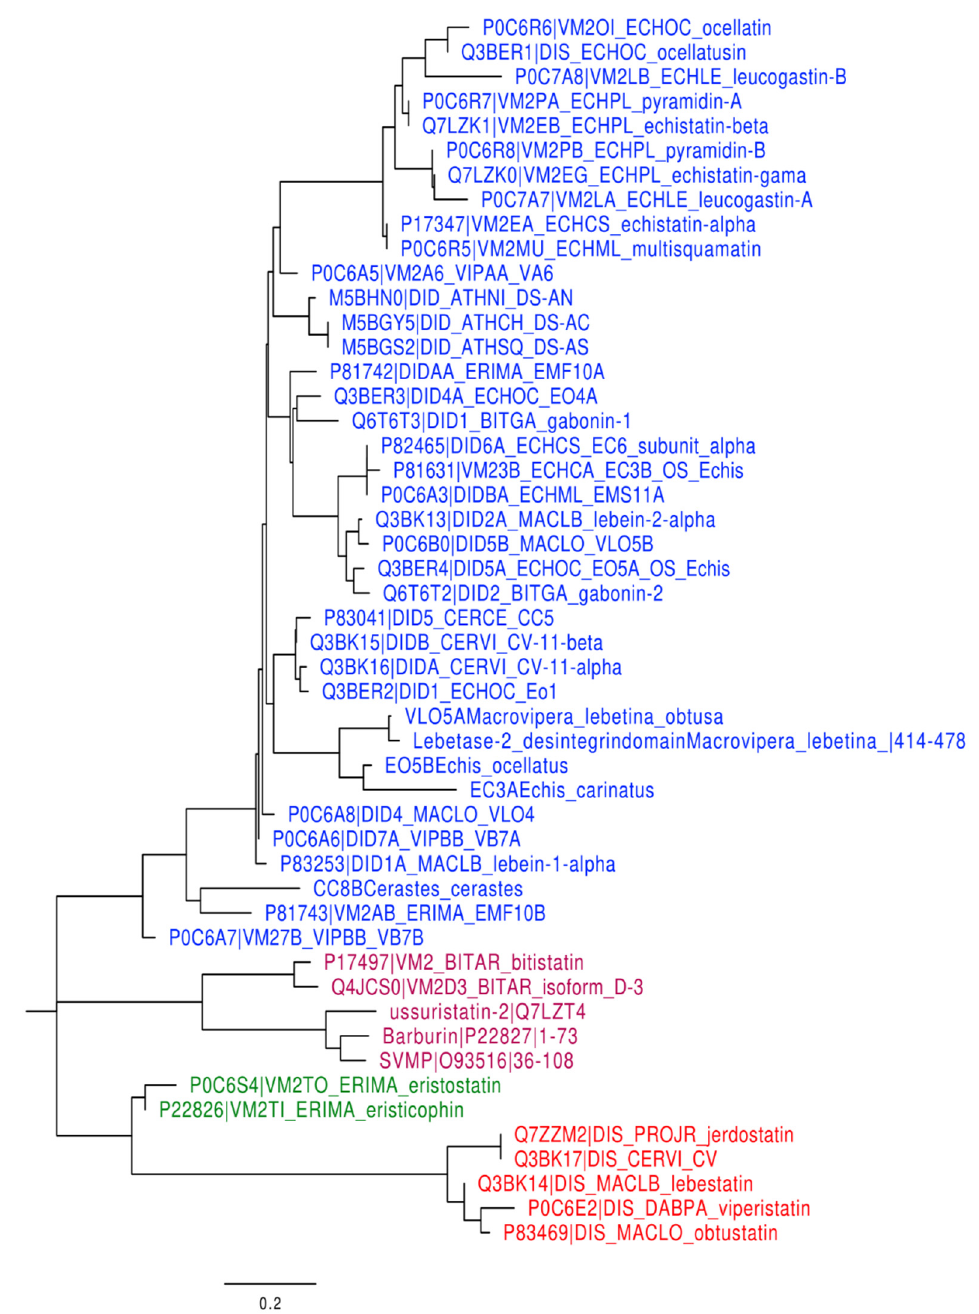
Figure 2. Phylogenetic tree of the disintegrins family. Phylogenetic analyses by JTT matrix-based method of all disintegrins family based on the RGD, KGD and R/KTS motifs. This analysis involved 50 amino acid sequences. Topology was supported by 1000 bootstrap replicates. The red color highlights the KTS-disintegrin family. Short disintegrins divided into groups, the color blue highlights the RGD group (24 disintegrins) and the RGD like group (14 disintegrins) includes seven MLD, five KGD, one MGD, four VGD and two WGD, Eristostatin group (green), KGD group (pink) and/RKTS (red).